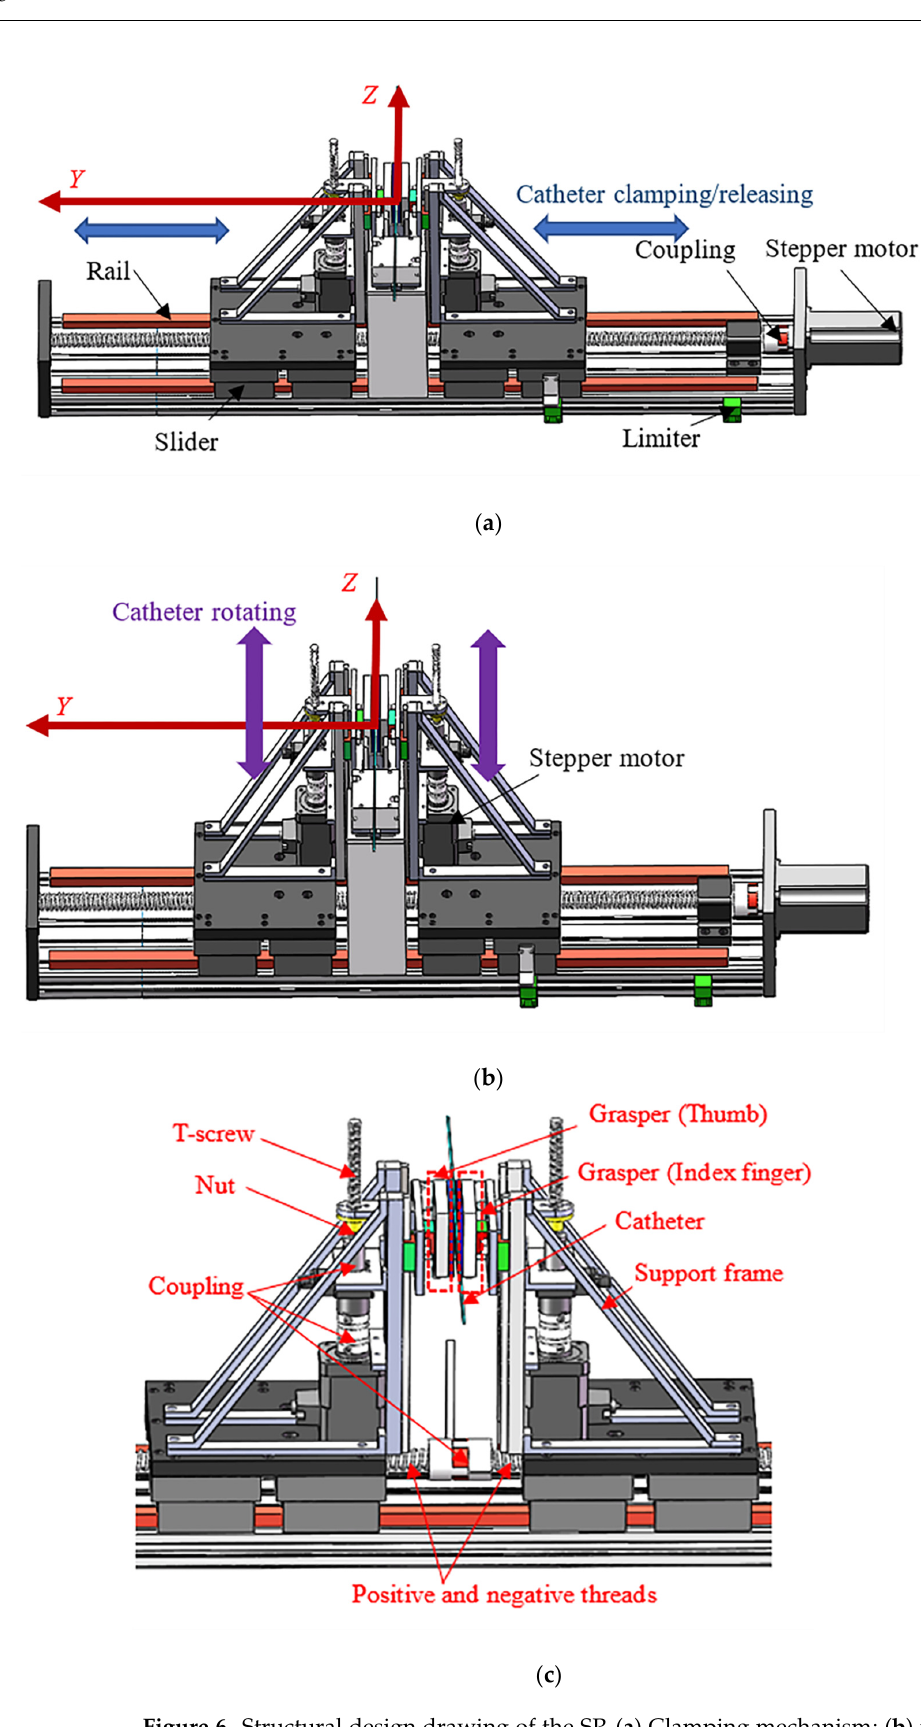
Figure 7. Schematic diagram of the SP inclined at a certain angle ( 𝜃 ). 3.3. Design of the Force Detection Structure In order to accurately realize the detection of the two forces (axial and radial force), the two-force-detection device is shown in Figure 8a. In this device, the radial force detec- tion of the catheter/guidewire adopts the commercial sensor: the torque sensor (RLW05m, Japan). A coupling connects the torque sensor shaft and the stepping motor shaft (ASM46AA, ORIENTAL MOTOR, Japan). The radial force of the catheter/guidewire is transmitted to the torque sensor through the combination of slider A and the related slide rail. The torque sensor recognizes the torque forces acting on the catheter/guidewire by detecting the slight change in torque in the motor shaft. It can be found that the torque force detection and identification in this study creatively use two torque sensors. Their main function is to compare the same or different torque forces detected by the two torque values. It can be judged whether the catheter/guidewire has slipped during the rotation